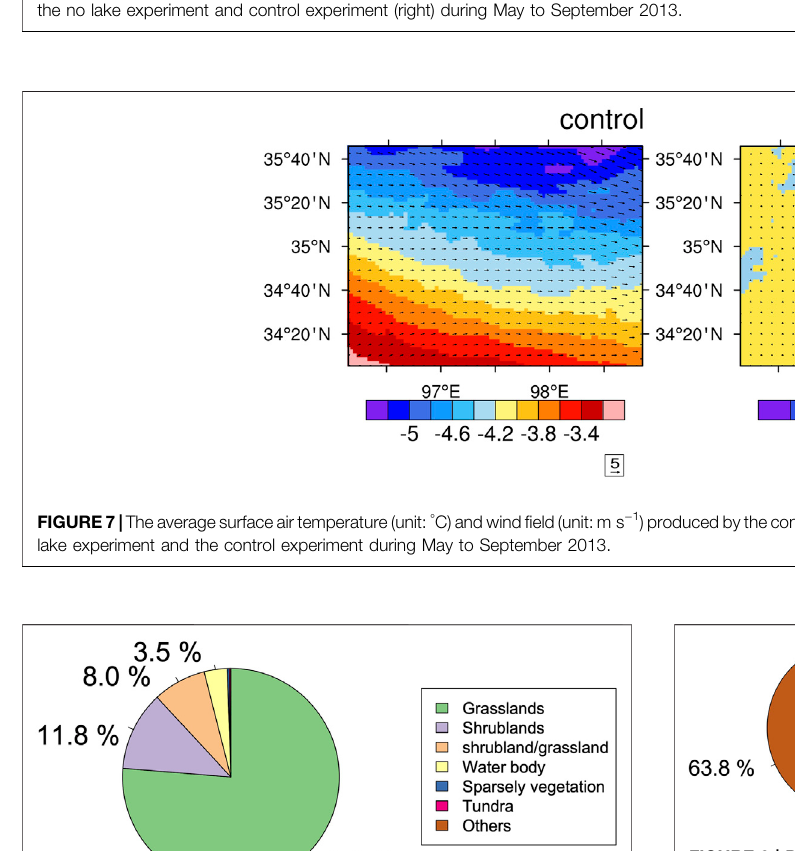
FIGURE 6 | The cumulative precipitation simulated by the control experiment with lakes (left), and the difference in the simulated cumulative precipitation between the no lake experiment and control experiment (right) during May to September 2013.